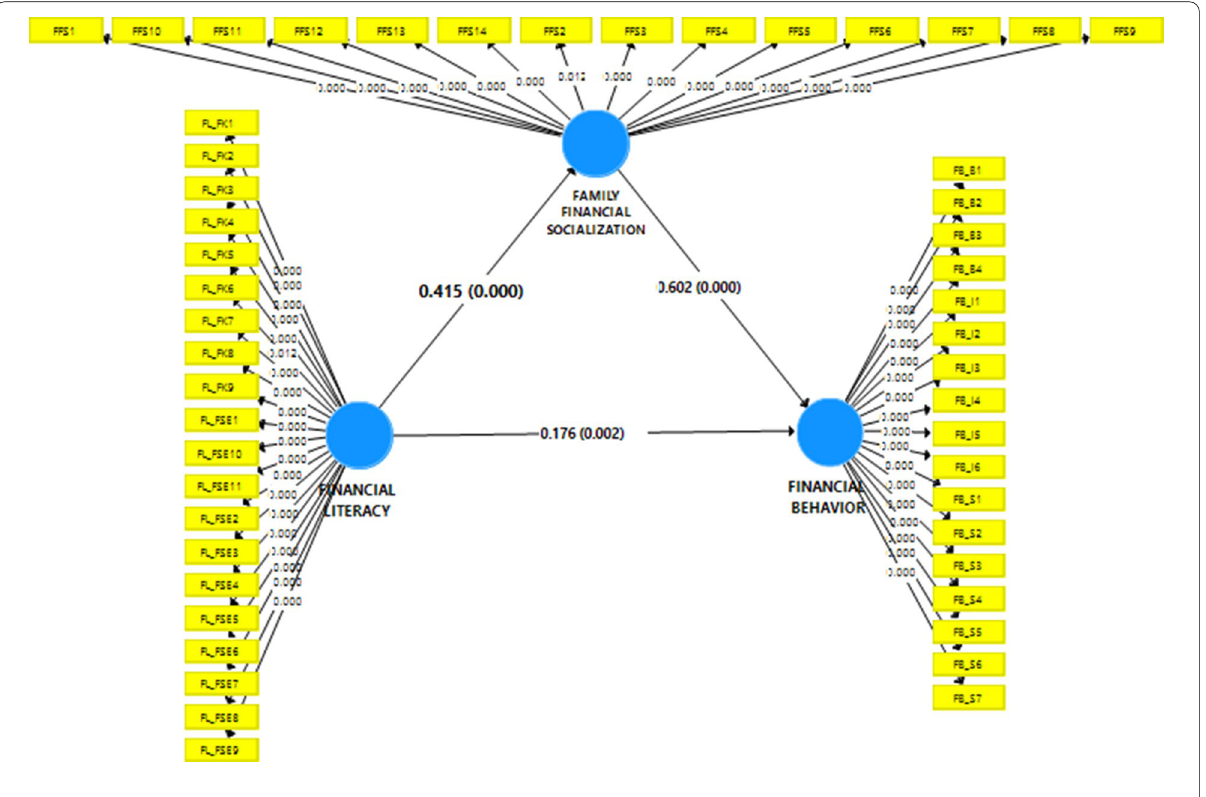
Fig. 2 Mediators Impact—Results using SmartPLS 3.0